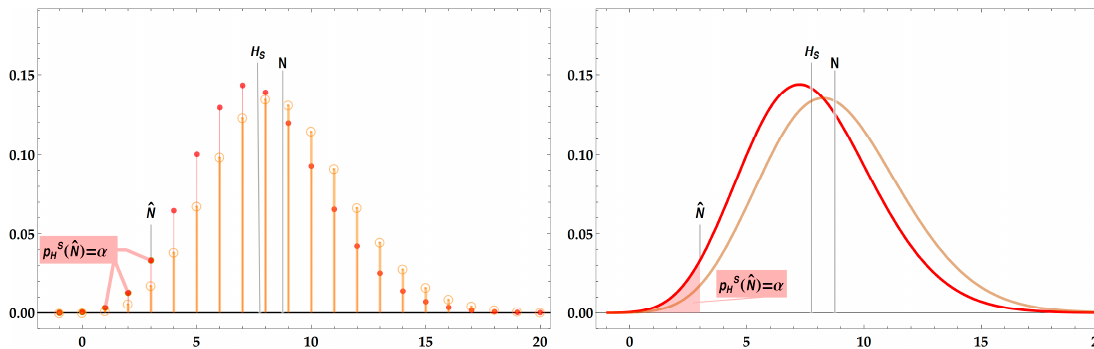
Figure 4. Illustration of the Poisson distribution model for left-tailed hypothesis testing with associated p S -value for ˆ N = 0 observed fibers at nominal significance level α = 5 %. The left image shows the Poisson probability density, the right its continuous generalization G, cf. Equation (A9). Table 8. Minimum number of fibers H S ( 0; α ) to expect to keep the p -value for observing zero fibers below the nominal significance level α .